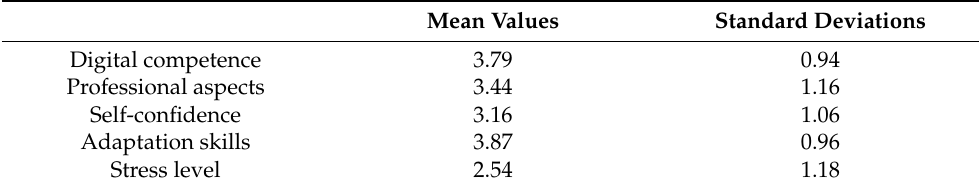
Table 7. Mean values and standard deviations of the subscales of the survey (ratings out of